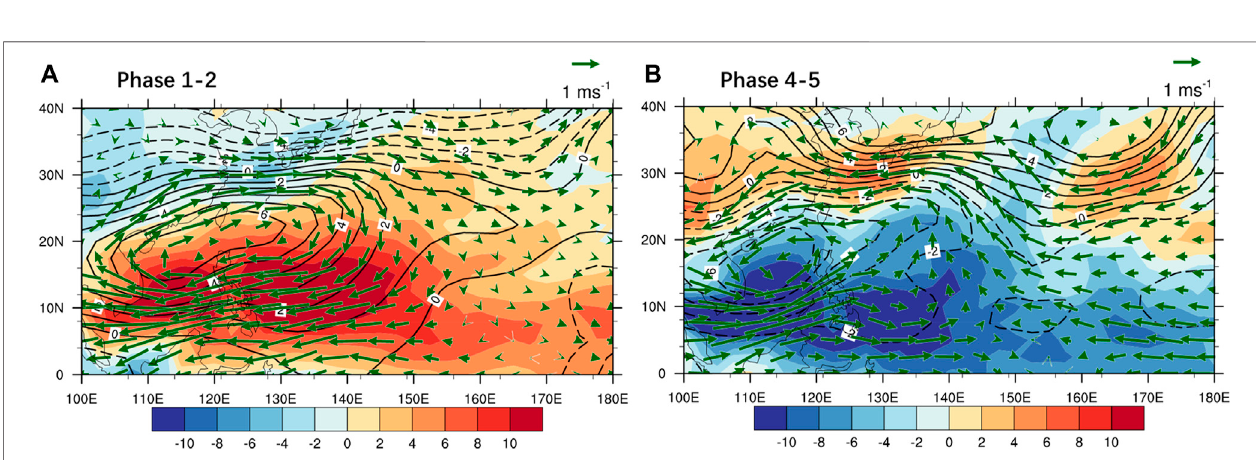
FIGURE9| Anomalouscompositesof500-hPageopotentialheight(contour,gpm),OLR(shading,W m − 2 ),and850-hPahorizontalwind(vector,m s − 1 )inMJO (A) phases 1 – 2 and (B) phases 4 – 5 during July – August of 1981 –